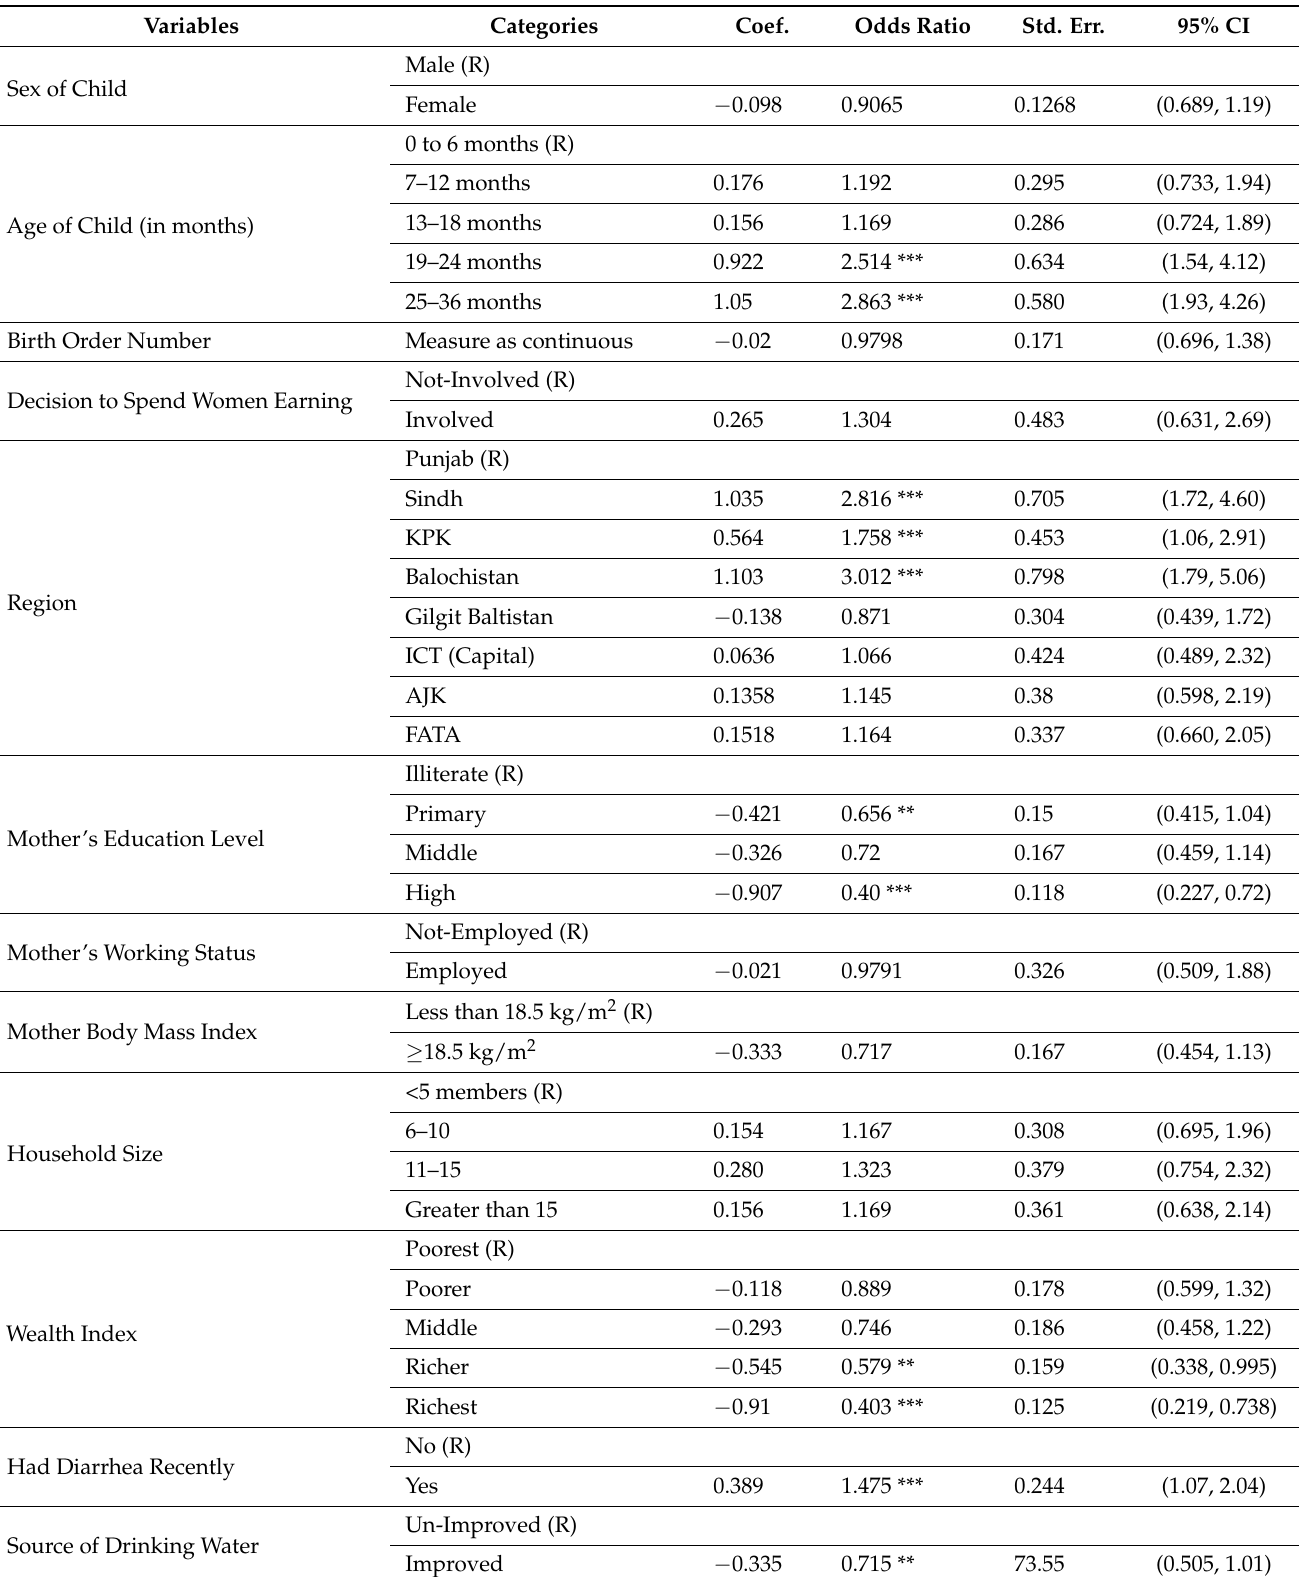
Table 3. Adjusted odds ratios for covariates of the CIAF based on logistic